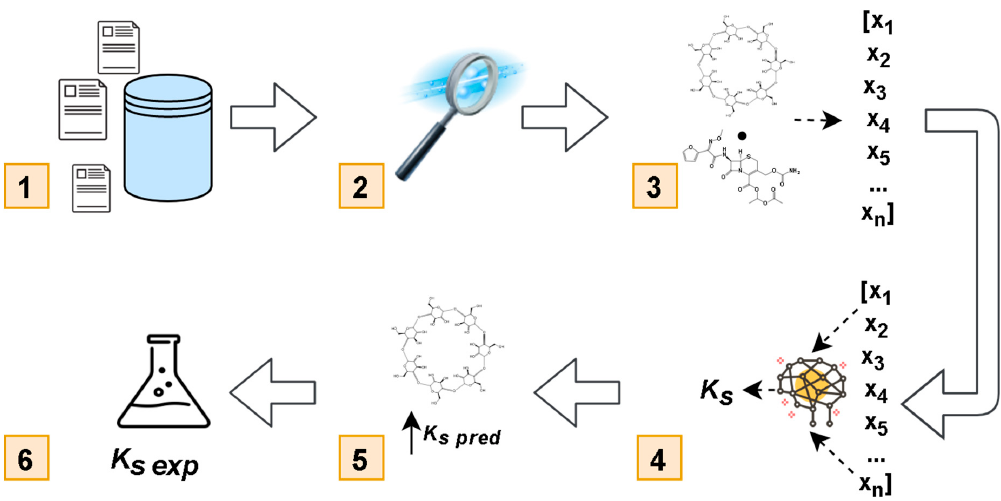
Figure 1. Study design: data collection (1); data curation (2); descriptors calculation (3); model development (4); ln(K s ) prediction (5); experimental validation (6).